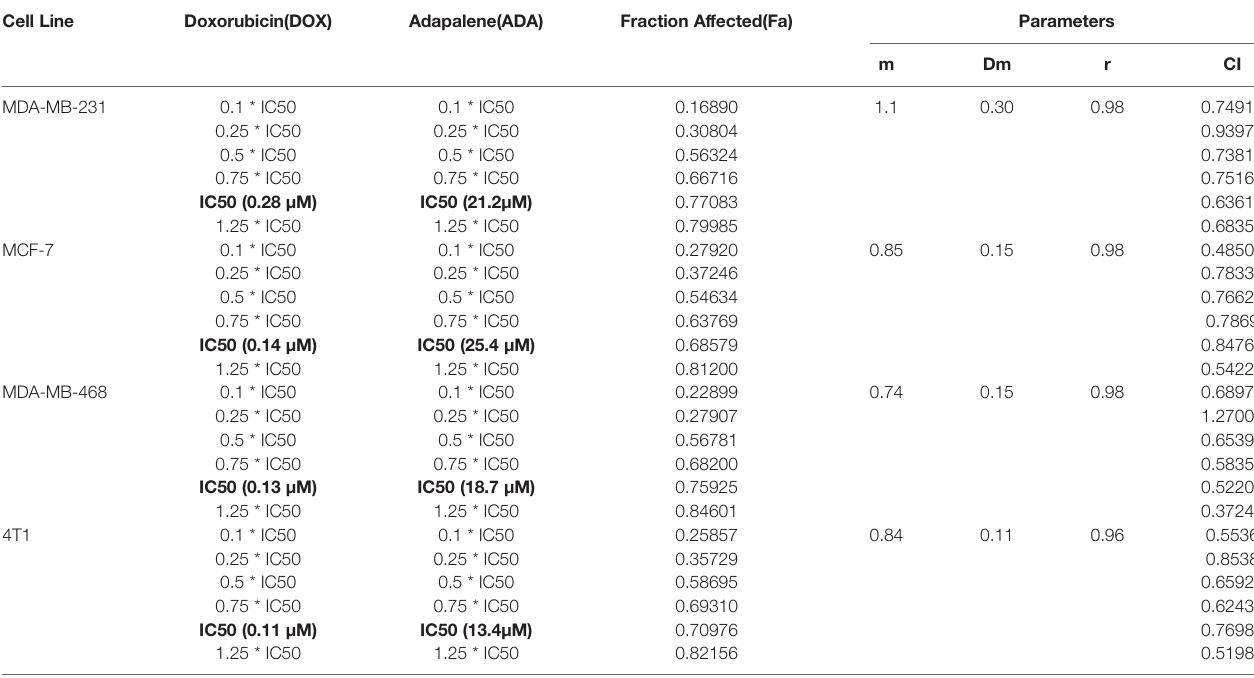
TABLE 1 | Experimental Design and data summary of the dose-effect curve and Chou-Talalay parameters of doxorubicin and adapalene drug combinations against breast cancer cell lines after 72 hrs treatment period. Cell